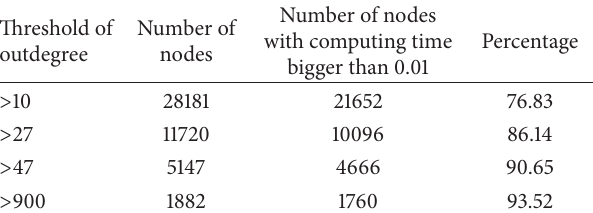
Table2:ThresholdofoutdegreeandcomputingtimeofBAnetwork.